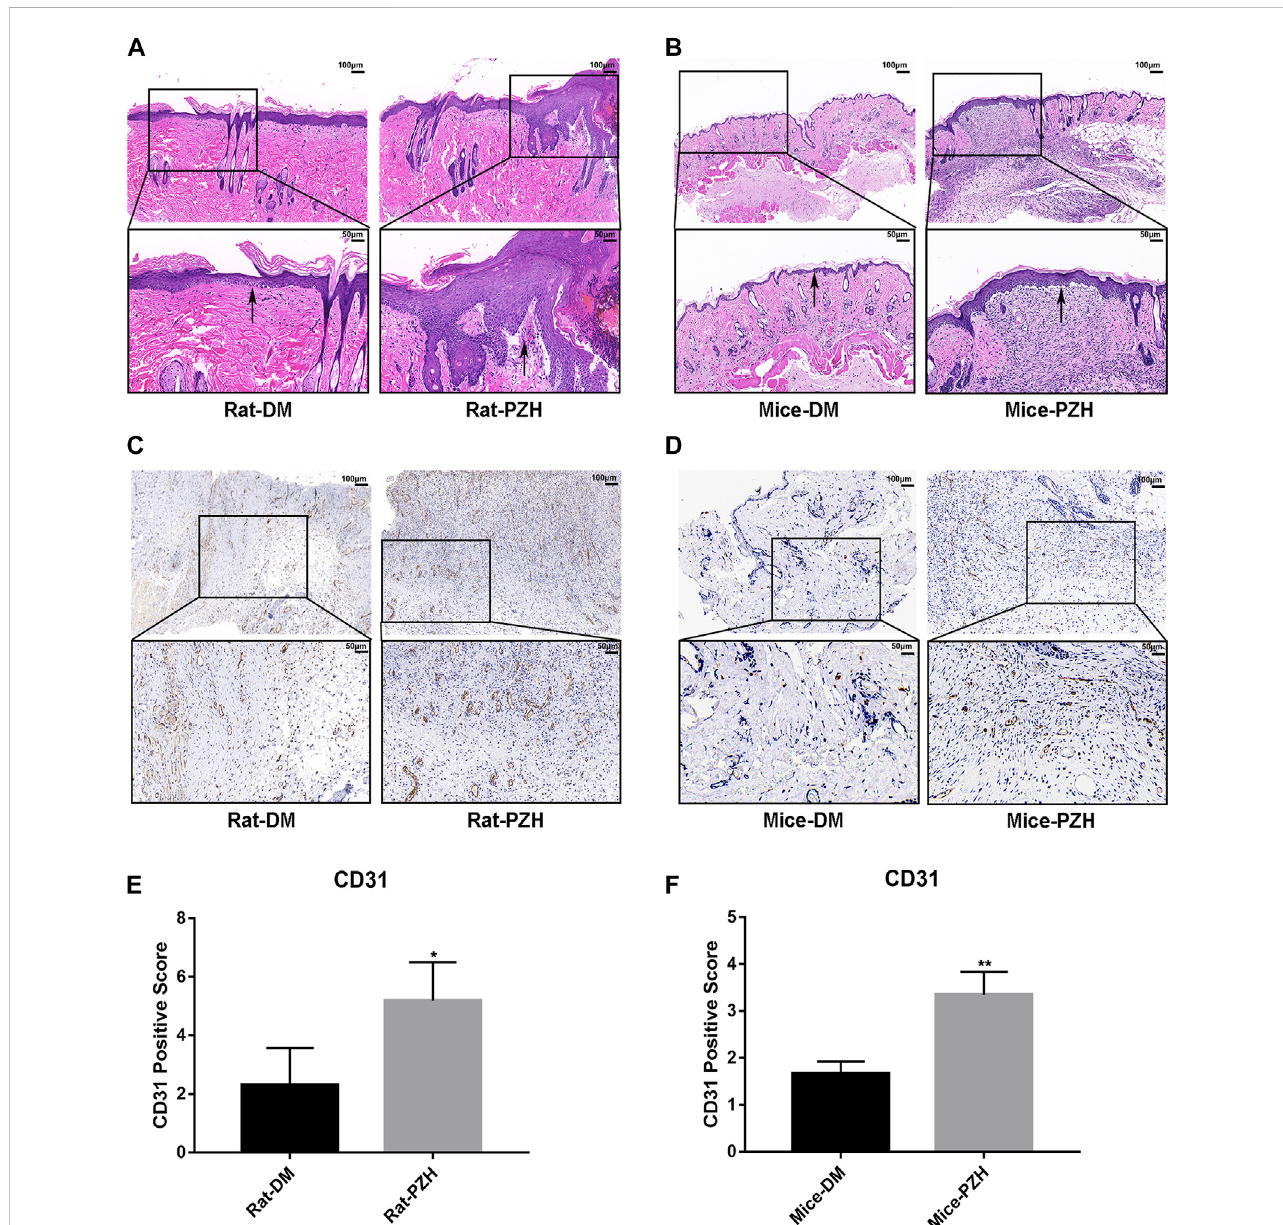
FIGURE 2 PZH accelerated the re-epithelialization and angiogenesis of diabetic rat/mice wounds. (A,B) On the eighth/10th day of topical/gavage treatment with PZH, images of H&E staining (scale bar = 100 μ m, magni fi cation ×100; scale bar = 50 μ m, magni fi cation ×200) of wound skin tissue sections of different groups of rats (A) or mice (B) were examined under a light microscope. Black arrow: epithelial layer. DM: diabetic control group; PZH: PZH-treated group. (C – F) Histological images of CD31 staining and quantitative analysis of wound tissue in different groups of rats (C,E) or mice (D,F) under a light microscope. Blood vessels were stained for CD31, and brown staining was positive for CD31. * p < 0.05 (n = 4), ** p < 0.01 (n = 3). Data are expressed as the mean ±